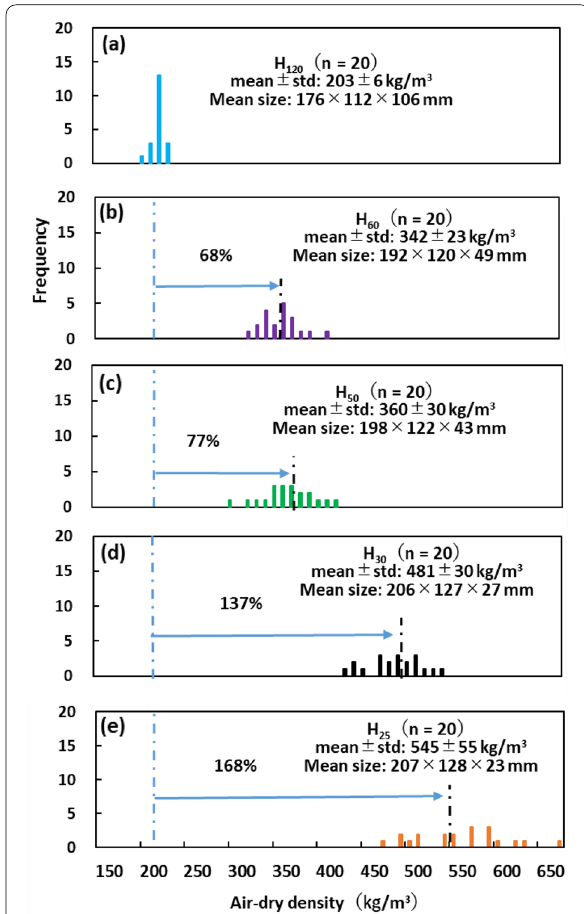
Fig. 2 Air-dry density distribution of the waste mushroom bed. a H 120 , b H 60 , c H 50 , d H 30 , e H